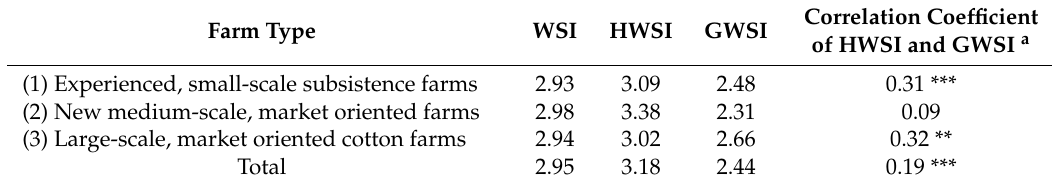
Table 4. Hydrology and governance dimensions of water security across farm